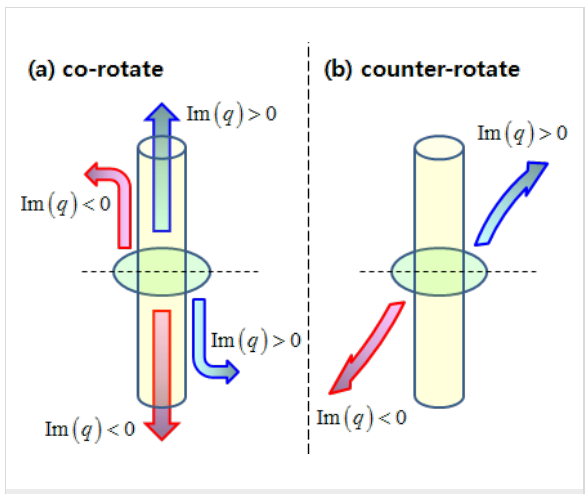
Figure 9: Schematic for the Poynting-vector flows. (a) Co-rotational case. (b) Counter-rotational case. Spin sifters can be devised according to the helicity σ